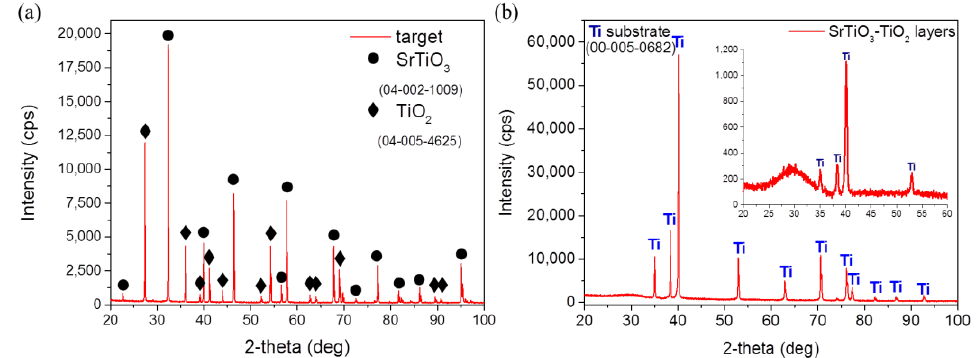
Figure 2. X-ray diffraction of ( a ) prepared target for sputtering revealing SrTiO 3 and TiO 2 phases and ( b ) SrTiO 3 -TiO 2 layers deposited on Ti substrate with the 220 min long sputtering process. The inset represents GIXD patterns focused on 2-theta range of 20–60 deg. The XRD card numbers were put in the brackets for SrTiO 3 , TiO 2 and